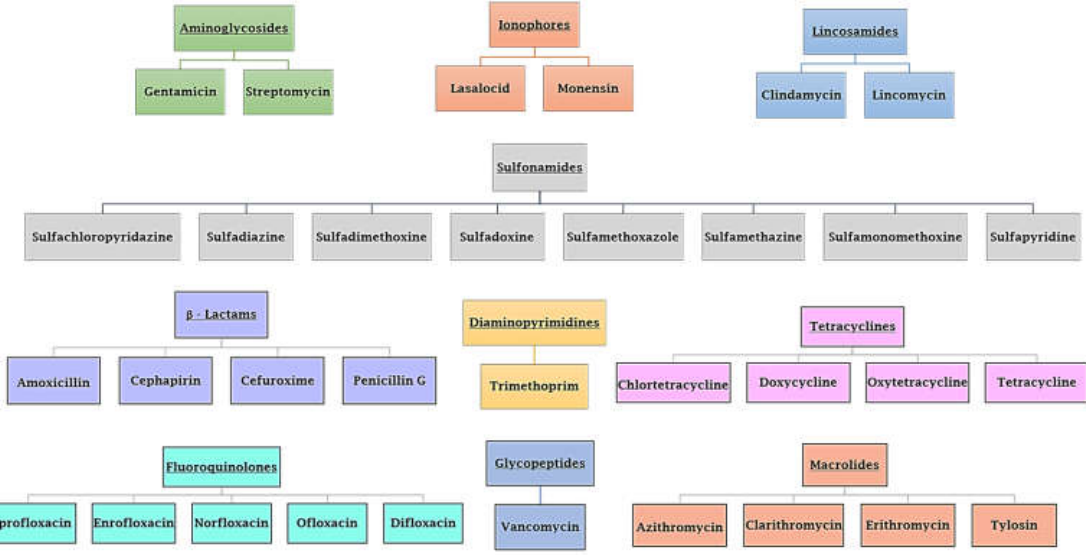
Figure 1. Various types of FDA-approved antibiotics. Class and antibiotic name are reported.